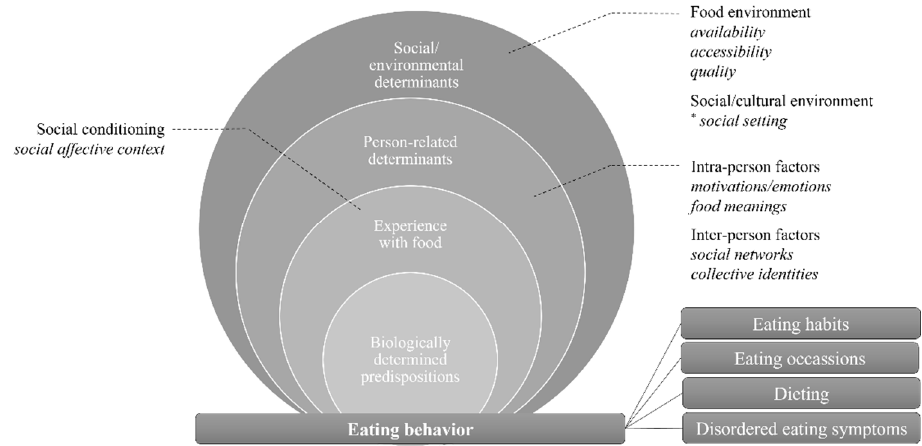
Figure 2. Food behavior variables of analog eating behavior linked to digital food communication (adapted from Contento and Koch, 2021, p. 50). * Variable not directly investigated in reviewed studies, but inferred from results of review